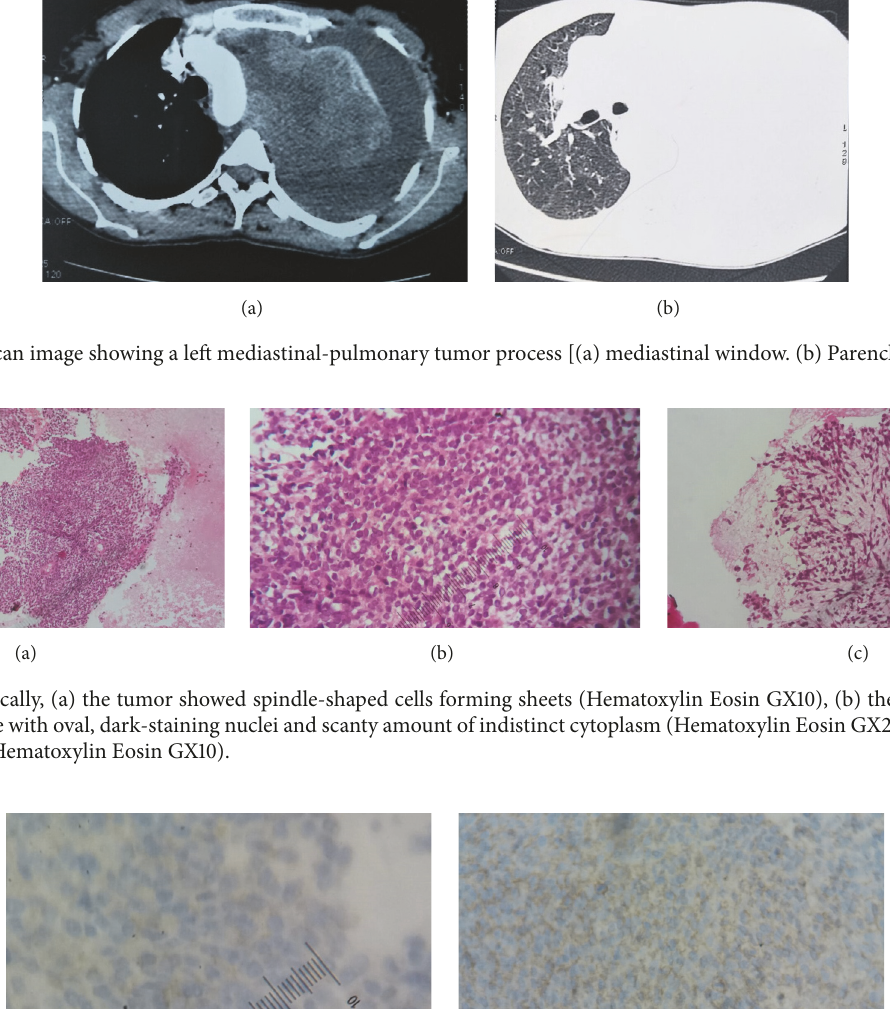
diffusely positive to epithelial markers. After discarding